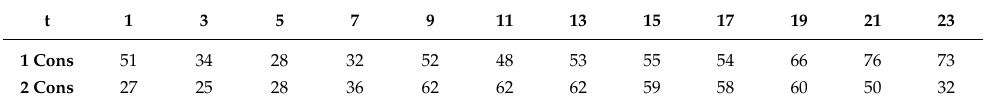
Table A1. Loads of two types of consumers that comprise the electric power system during the day.